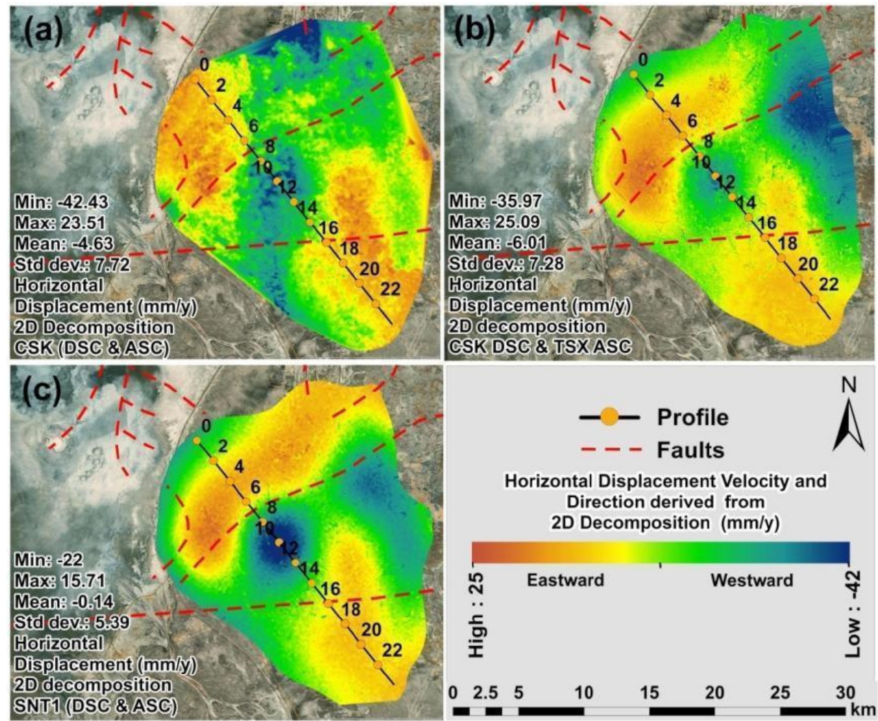
Figure 14. Maps with profiles of horizontal displacement velocity (2018–2020) derived from 2D de- compositions of: ( a ) CSK DSC/CSK ASC tracks; ( b ) CSK DSC/TSX ASC tracks; ( c ) SNT1 DSC/SNT1 ASC